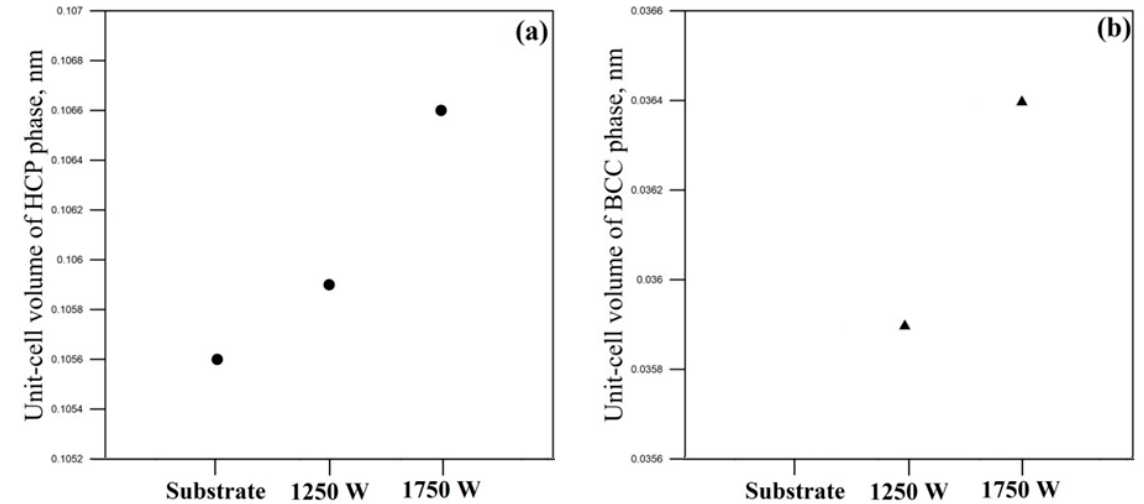
Figure 7. Unit-cell volumes of the hcp ( a ) and bcc ( b ) phases of the specimens alloyed with different beam powers.